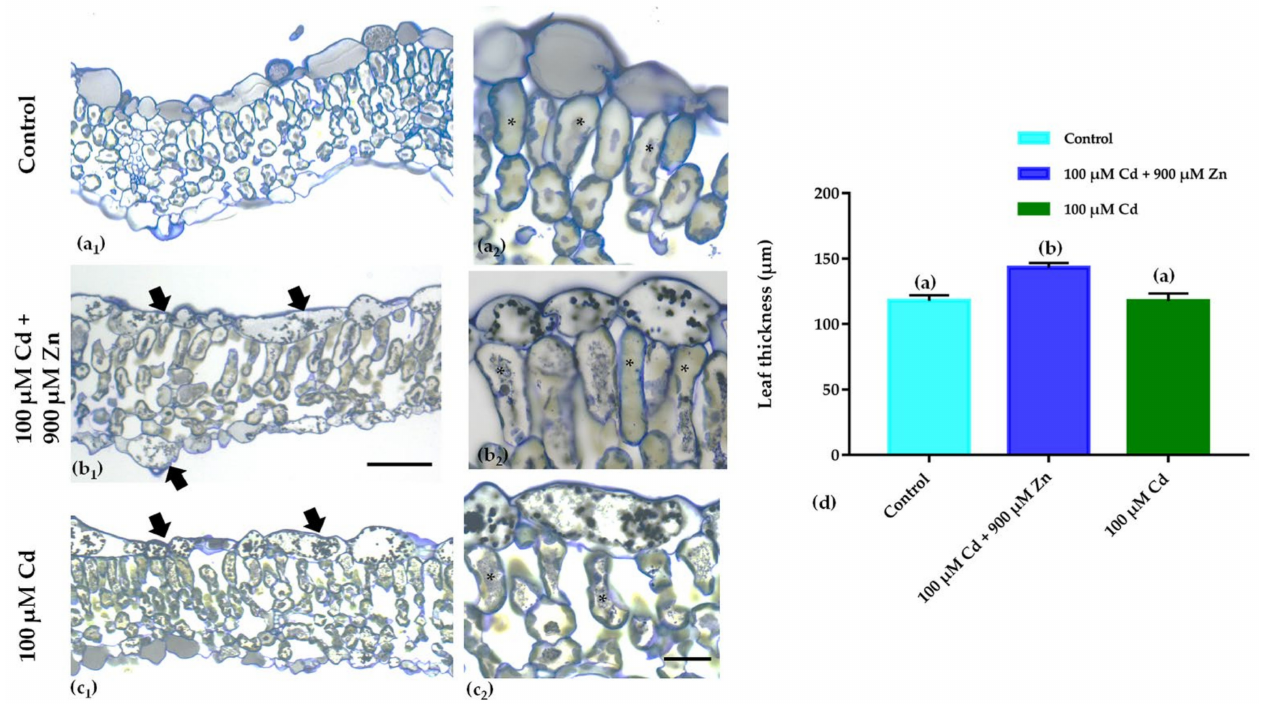
Figure 3. Leaf cross-sections ( a 1 – c 2 ) and leaf thickness measurements ( d ) of the control ( a 1 , a 2 ), 100 µ M Cd + 900 µ M Zn ( b 1 , b 2 ), and 100 µ M Cd ( c 1 , c 2 ) of 8-day-treated Salvia sclarea plants. Increased magnification images of the adaxial epidermis and palisade mesophyll cells are depicted in ( a 2 , b 2 , c 2 ). Upon 100 µ M Cd application, the cells of the adaxial epidermis were filled with osmiophilic granules (arrows in ( c 1 , c 2 )), which in the combined (Cd + Zn) treatment were also present in the abaxial epidermal cells (arrows in ( b 1) ). Moreover, the palisade mesophyll cell structure was compromised in 100 µ M Cd-treated plants (asterisks in ( c 2 )), while after the combined exposure, it was similar to the control (asterisks in ( b 2 ) and ( a 2 )). The combined treatment also seemed to increase leaf thickness ( d ). Scale bar in ( a 1 , b 1 , c 1 ): 50 µ m. Scale bar in ( a 2 , b 2 , c 2 ): 10 µ m. Different letters in ( d ) indicate significant differences ( p < 0.05, n =